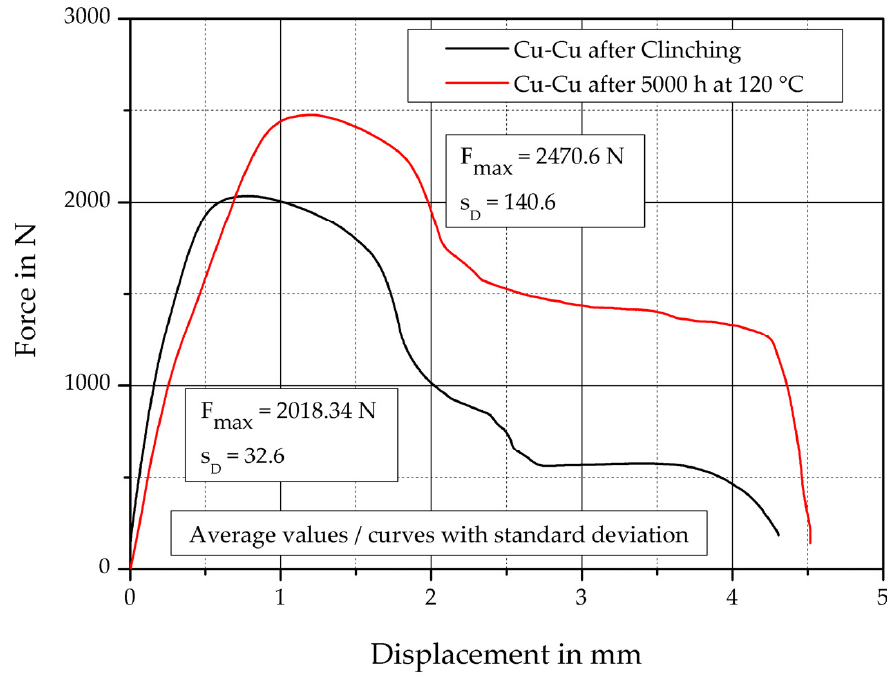
Figure 10. Quasistatic shear load—comparison of Cu-Cu clinch joints after long-term tests .